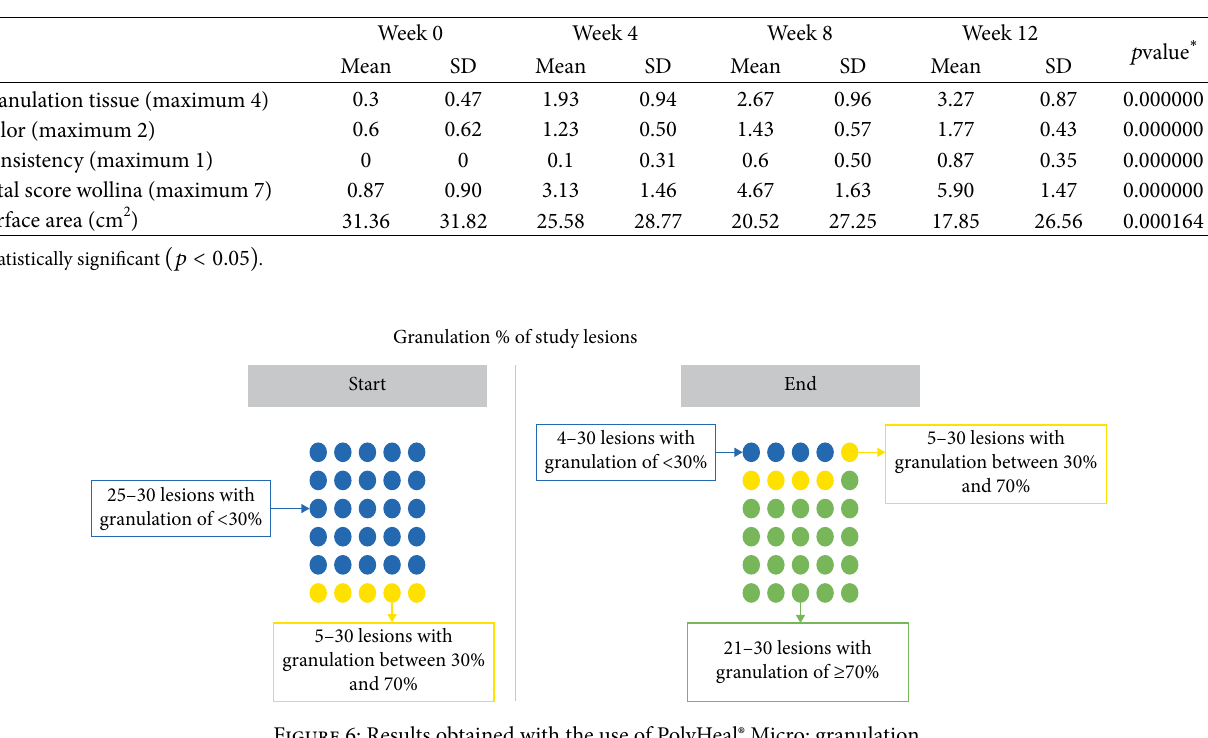
Table 8: Wollina score.